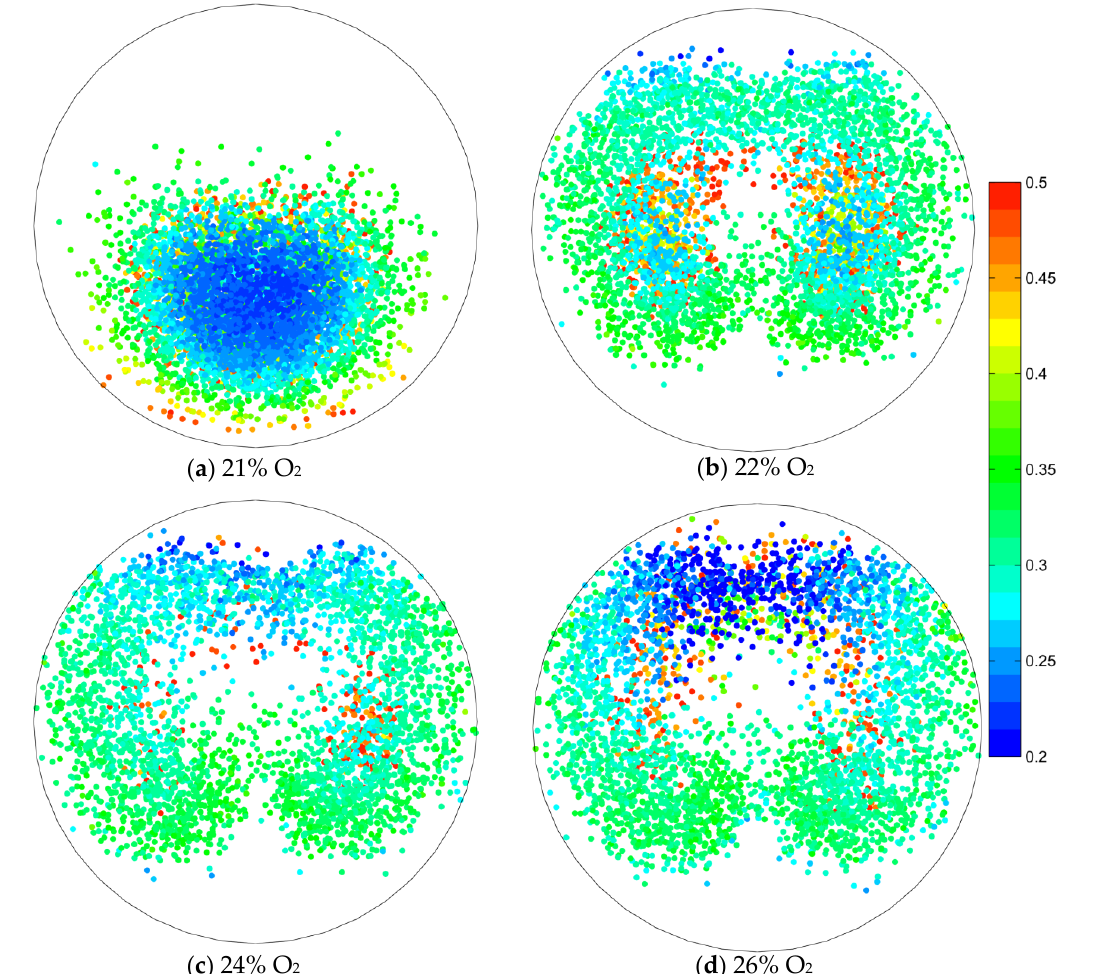
Figure 10. Migration of targeted area under targeted oxygen-enrichment.